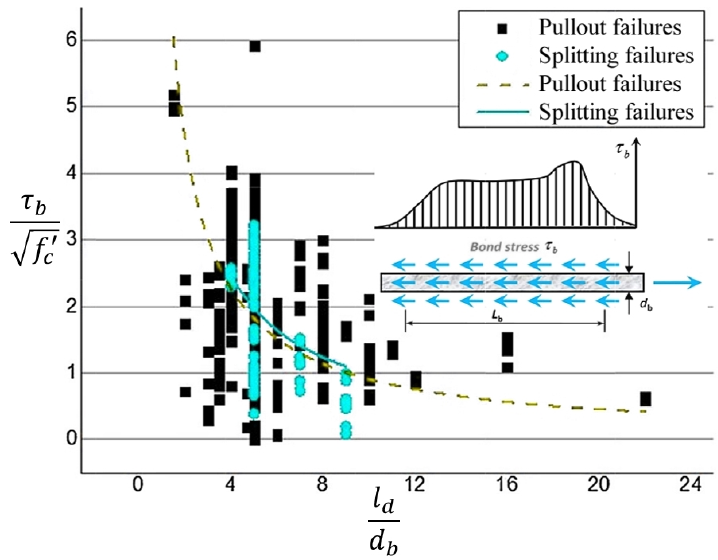
Figure 7. Effect of embedment length on bond strength [38].